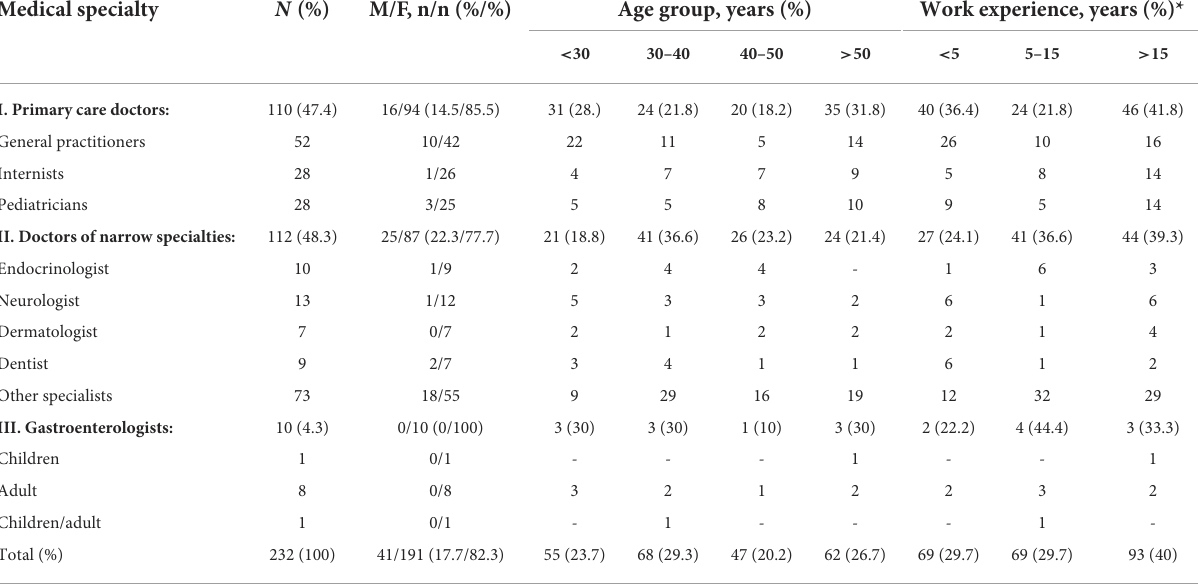
TABLE 1 Medical specialty, gender, age, and work experience of respondents participated in the survey. Medical specialty